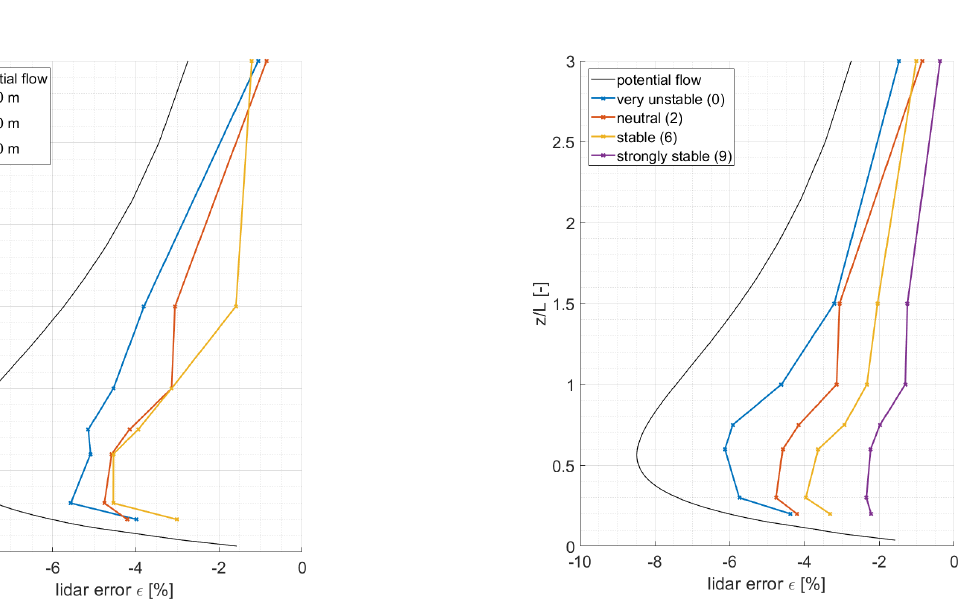
Figure 10. Model comparison between WAsP Engineering (a) and Meteodyn WT (b) for different roughness lengths for an H/L ratio of 0.3. Lidar error ε in dependence of the roughness length z 0 between z/L ratios from 0 to 3. Results from the potential flow model (black) are shown as a reference.